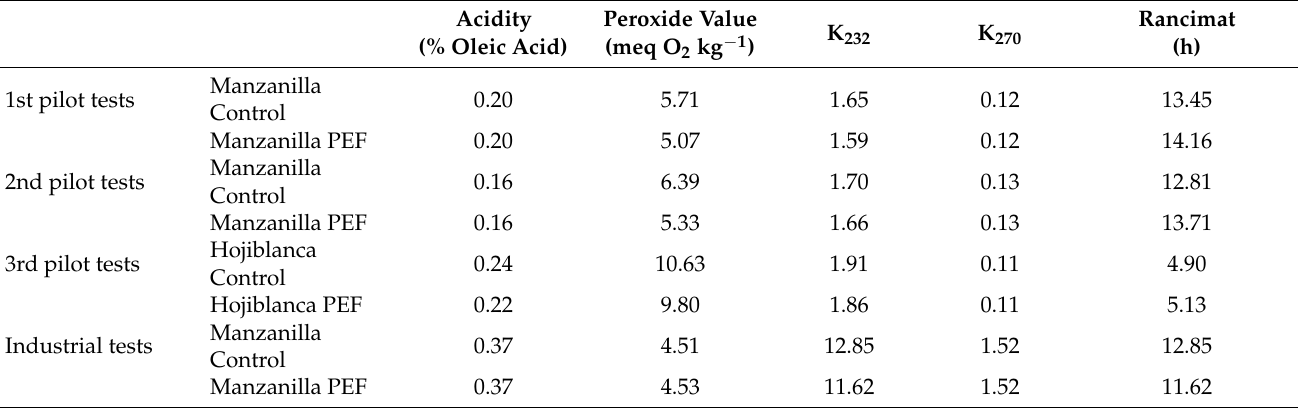
Table 3. Trade standards for olive oils from cultivars ‘Manzanilla’ and ‘Hojiblanca’ extracted with a standard protocol (Control) and by applying pulsed electric field (PEF) technology.